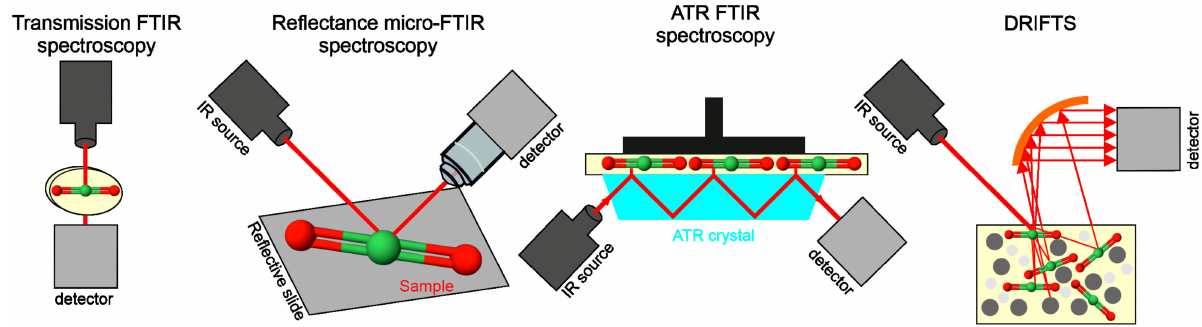
Figure 2. The schematic representations of main FTIR techniques used in analysis of polysaccharide